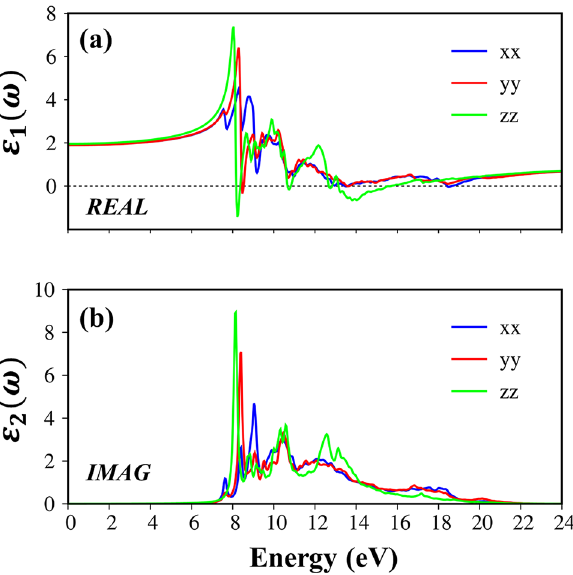
Figure 6. ( a ) The real-part and ( b ) imaginary-part of dielectric functions with the excitonic effects under x-/y-/z- polarization directions (the blue, red and green curves).